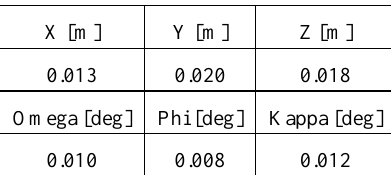
Table 2. Predicted accuracy of EO